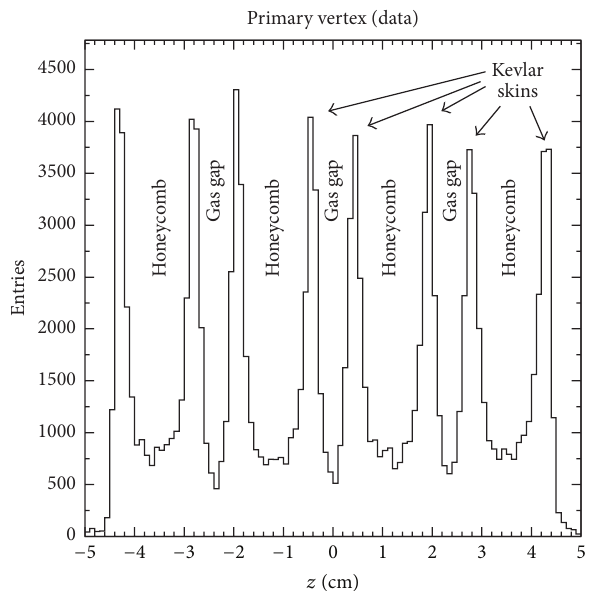
Figure 3: Distribution of vertices through one drift chamber along the beam direction (from